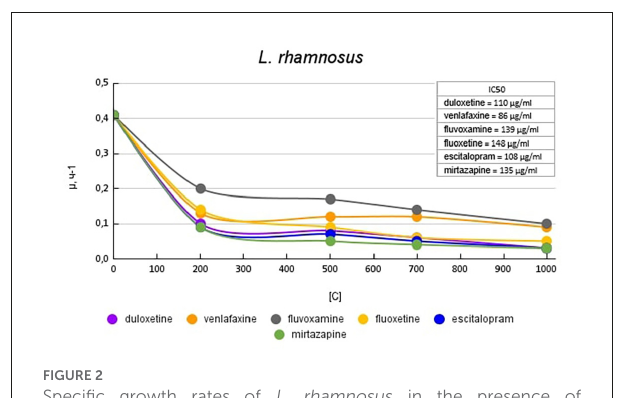
FIGURE2 Specific growth rates of L. rhamnosus in the presence of